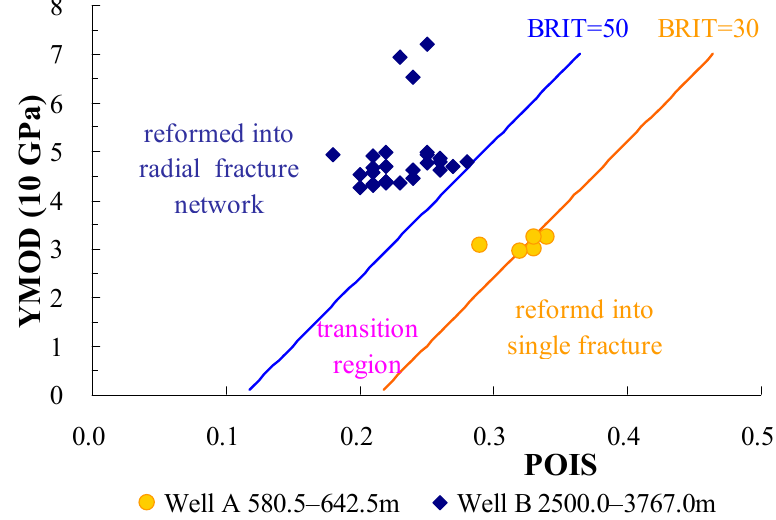
Figure 6. The POIS–YMOD evaluation plot for stimulated fractures in shale gas reservoirs.